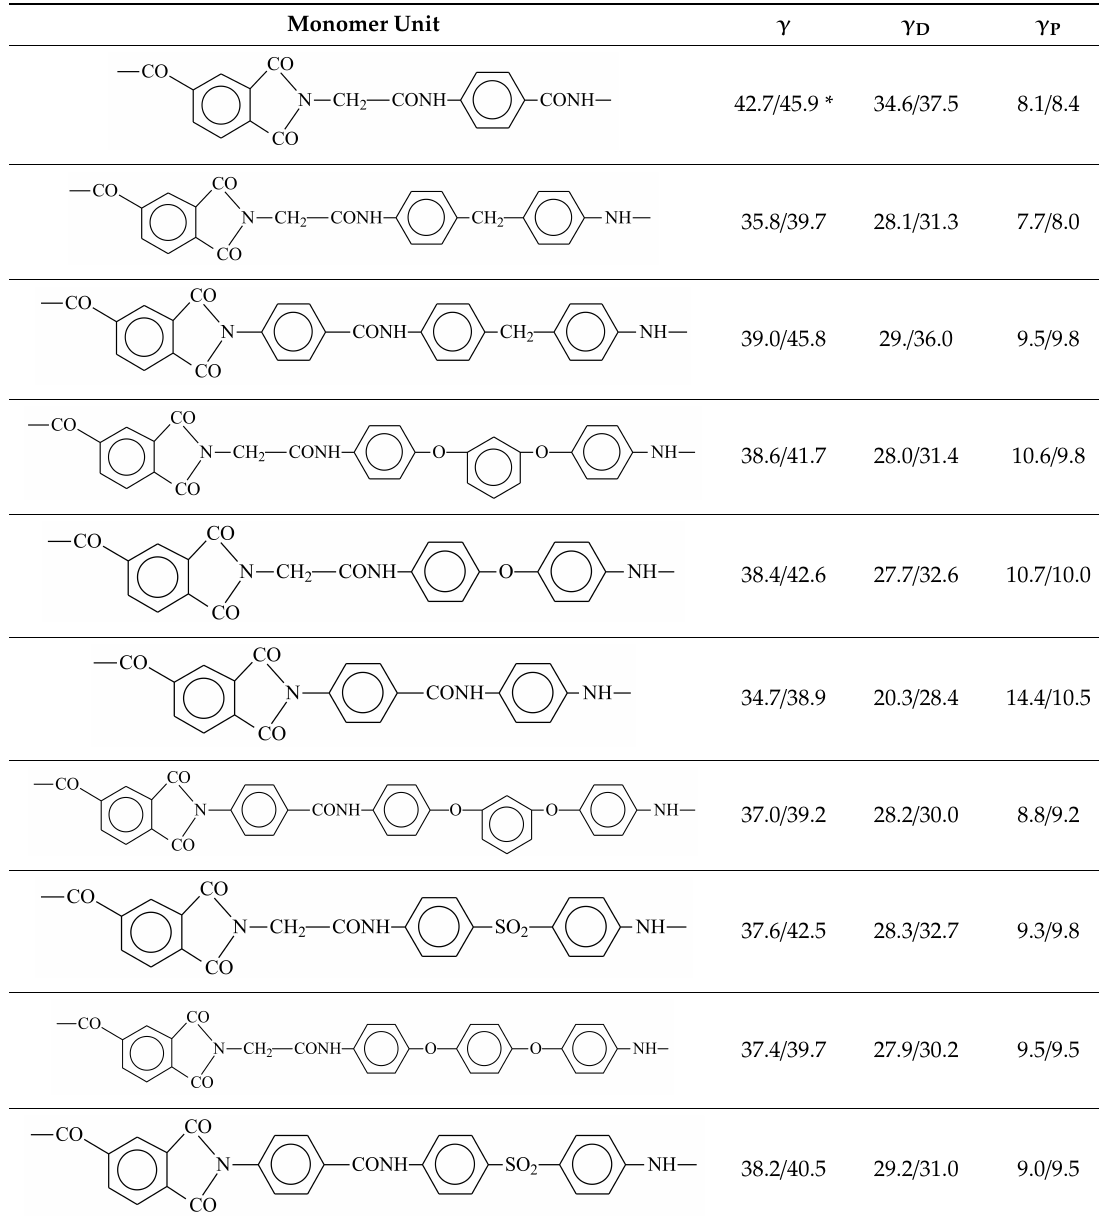
Table 3. Surface energy (mJ / m 2 ) of PAI with di ff erent structure of monomer